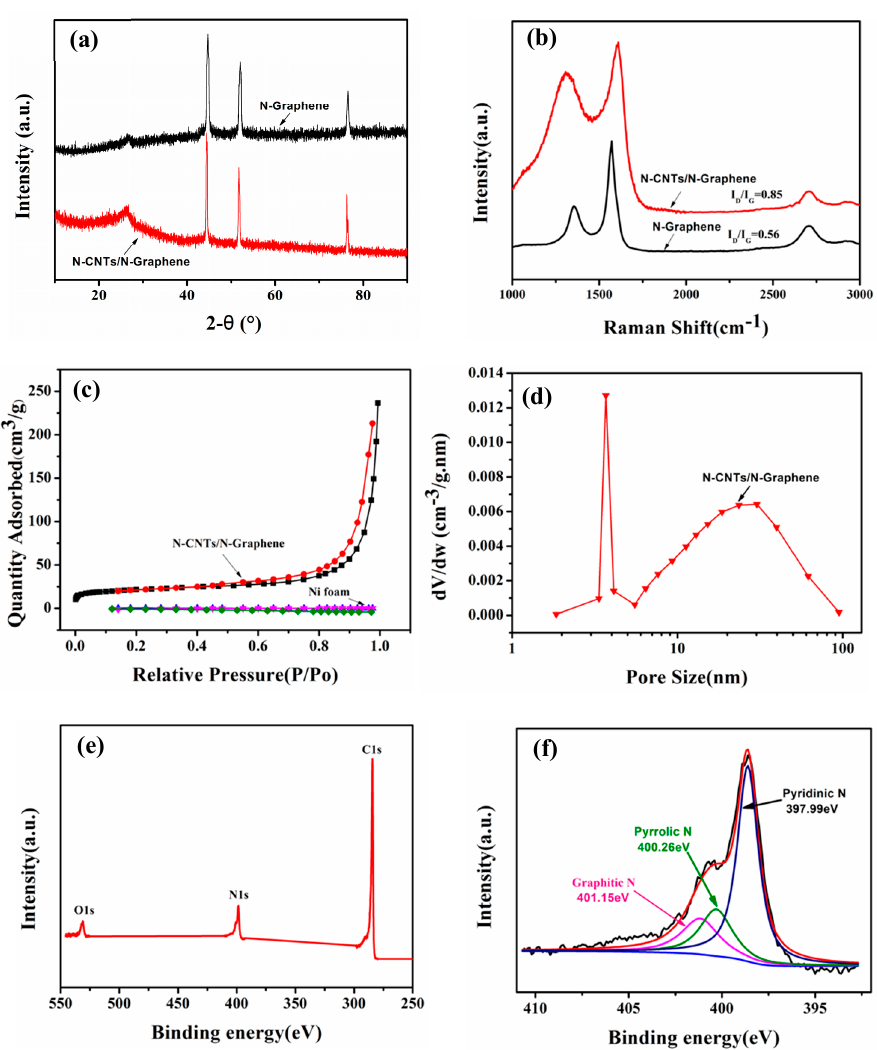
Figure 5. ( a ) XRD of N-CNTs/N-graphene and N-graphene; ( b ) Raman spectra of N-CNTs/N-graphene and N-graphene on the surface of NF; ( c ) N 2 adsorption-desorption curves of N-CNTs/N-graphene and NF; ( d ) Pore distribution of N-CNTs/N-graphene; ( e , f ) XPS spectrum and high-resolution XPS of N1s of N-CNTs/N-graphene.